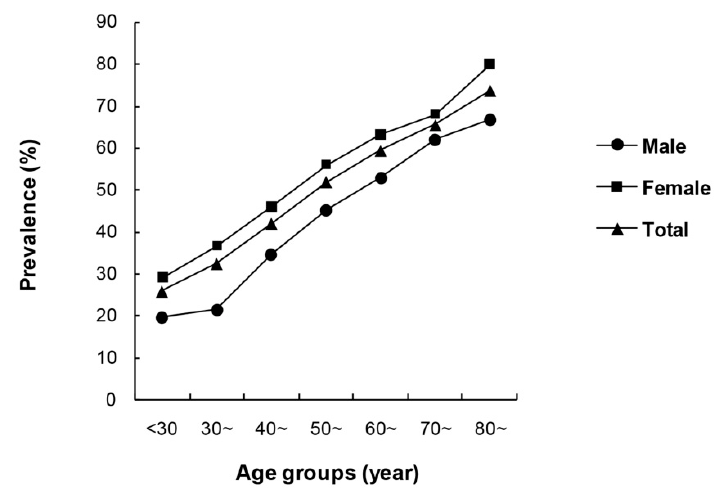
Figure 1. Comparison of the prevalence of thyroid nodules in different age subgroups.